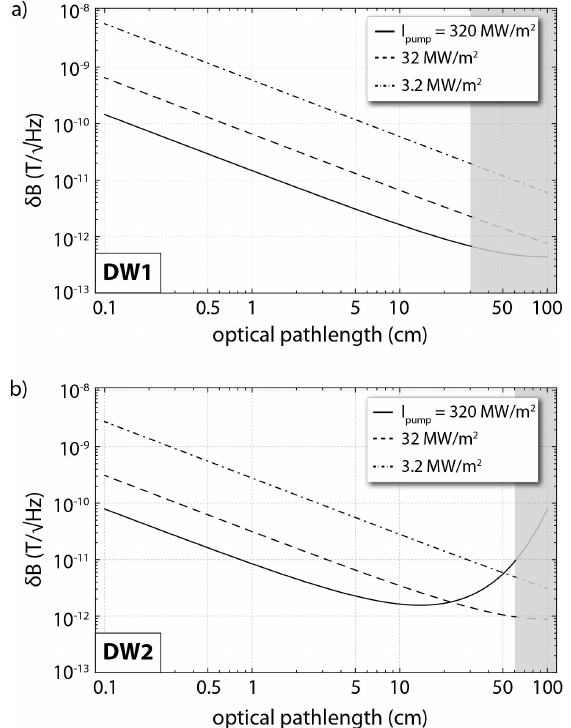
Figure 5. Projected IR photon shot-noise limited magnetic-field sensitivities as a function of the IR optical absorption path-length for and absorption-based magnetometric protocol employing ( a ) DW1, and ( b ) DW2. For the simulations we assume an input IR power of 30mW and a MW field with Rabi frequency of Ω R = 2 π × 1MHz. The shaded areas correspond to path-lengths not realisable with the corresponding waveguide, following the simulations shown in Figure